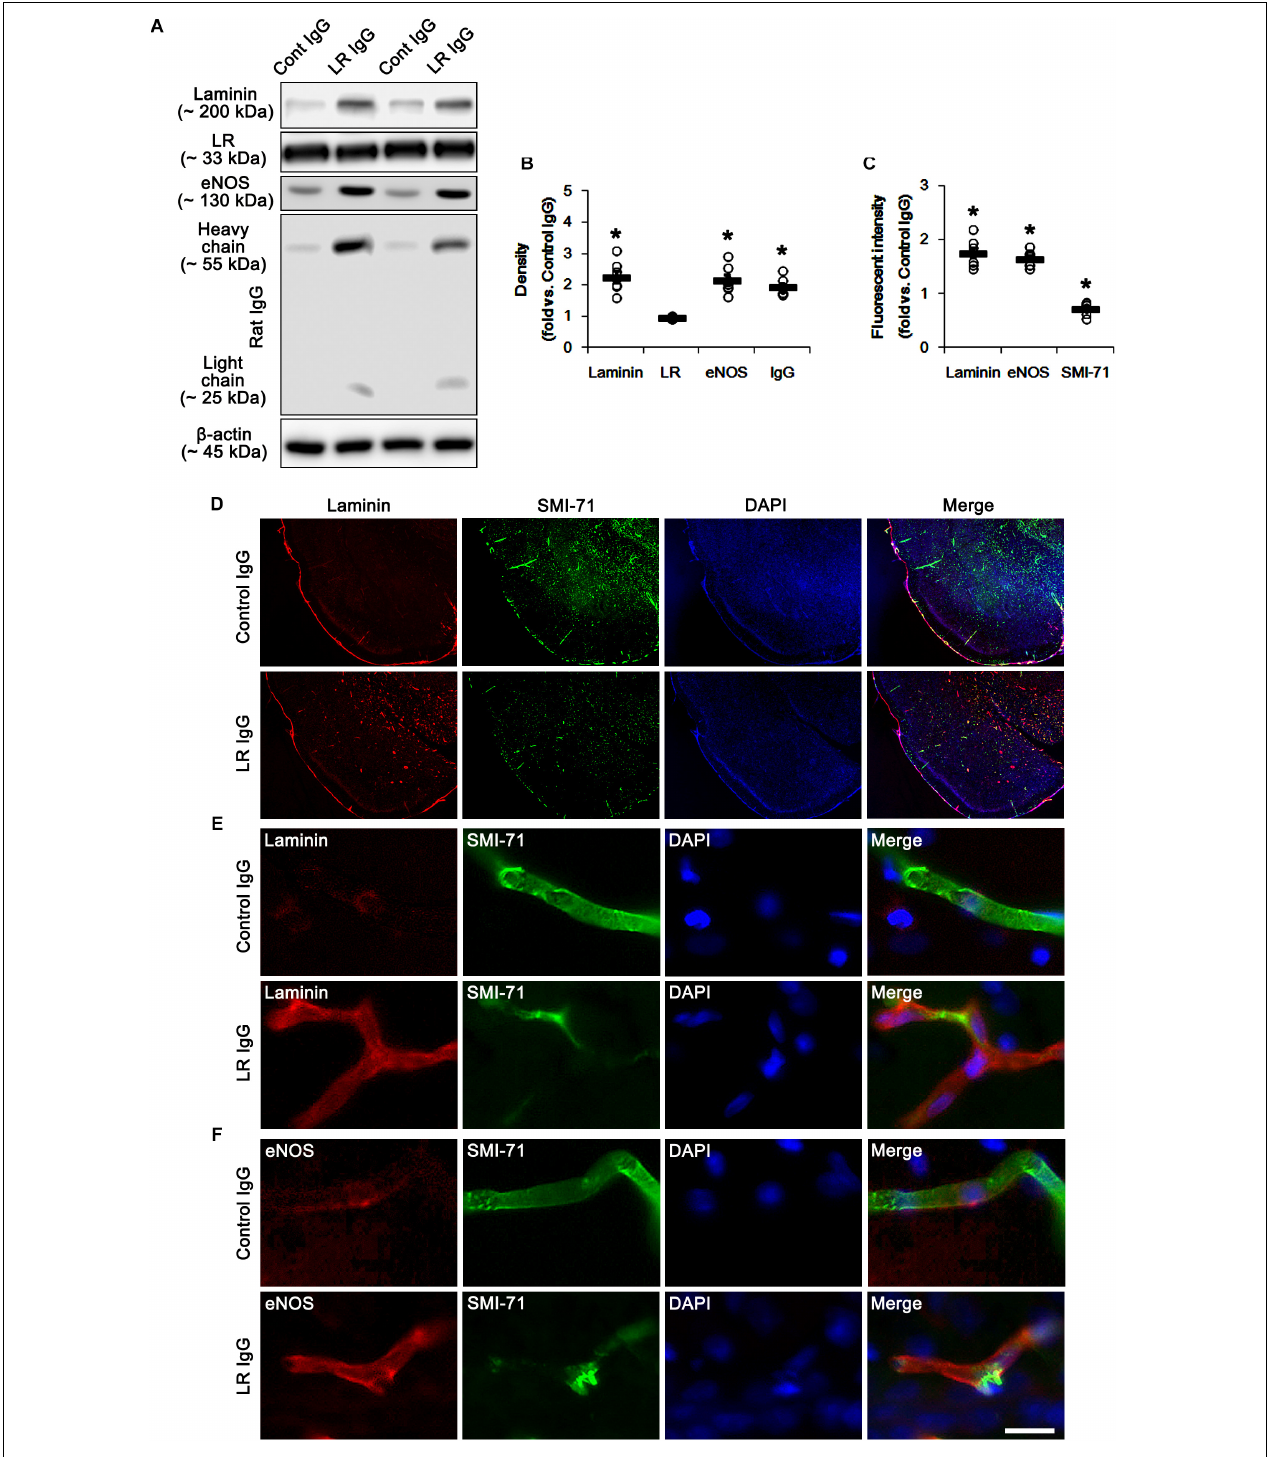
FIGURE 3 | 67-kDa LR (LR) neutralization-induced serum extravasation in normal animals. (A) Western blot image for expression levels of laminin, 67-kDa LR and eNOS, and serum extravasation induced by 67-kDa LR neutralization. 67-kDa LR IgG infusion increases expression levels of laminin and eNOS and serum extravasation, without changing 67-kDa LR expression. (B) Quantitative values (mean ± S.E.M) of the Western blot data concerning expression levels of laminin, 67-kDa LR and eNOS, and serum extravasation induced by 67-kDa LR neutralization ( n = 7, respectively). Open circles indicate each individual value. Horizontal bars indicate mean value. Significant differences are ∗ p < 0.05 vs. control IgG (Student t -test). (C) Quantitative values (mean ± S.E.M) of the fluorescent intensities of SMI-71, eNOS and laminin ( n = 7, respectively). Significant differences are ∗ p < 0.05 vs. control IgG (Student t -test). (D–F) Representative photographs of expression levels of laminin, eNOS, and SMI-71 in the PC. Bar = 400 µ m (D) and 12.5 µ m (E,F) .